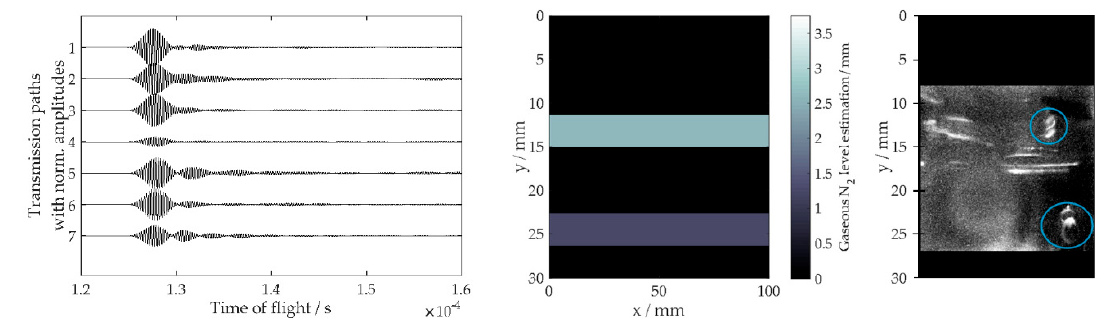
Figure 5. Detection of rising gaseous bubbles by ultrasound transmission measurement (received acoustic signals ( left ) and image plot ( centre )) and recorded picture from side-view observation with bubbles ( right